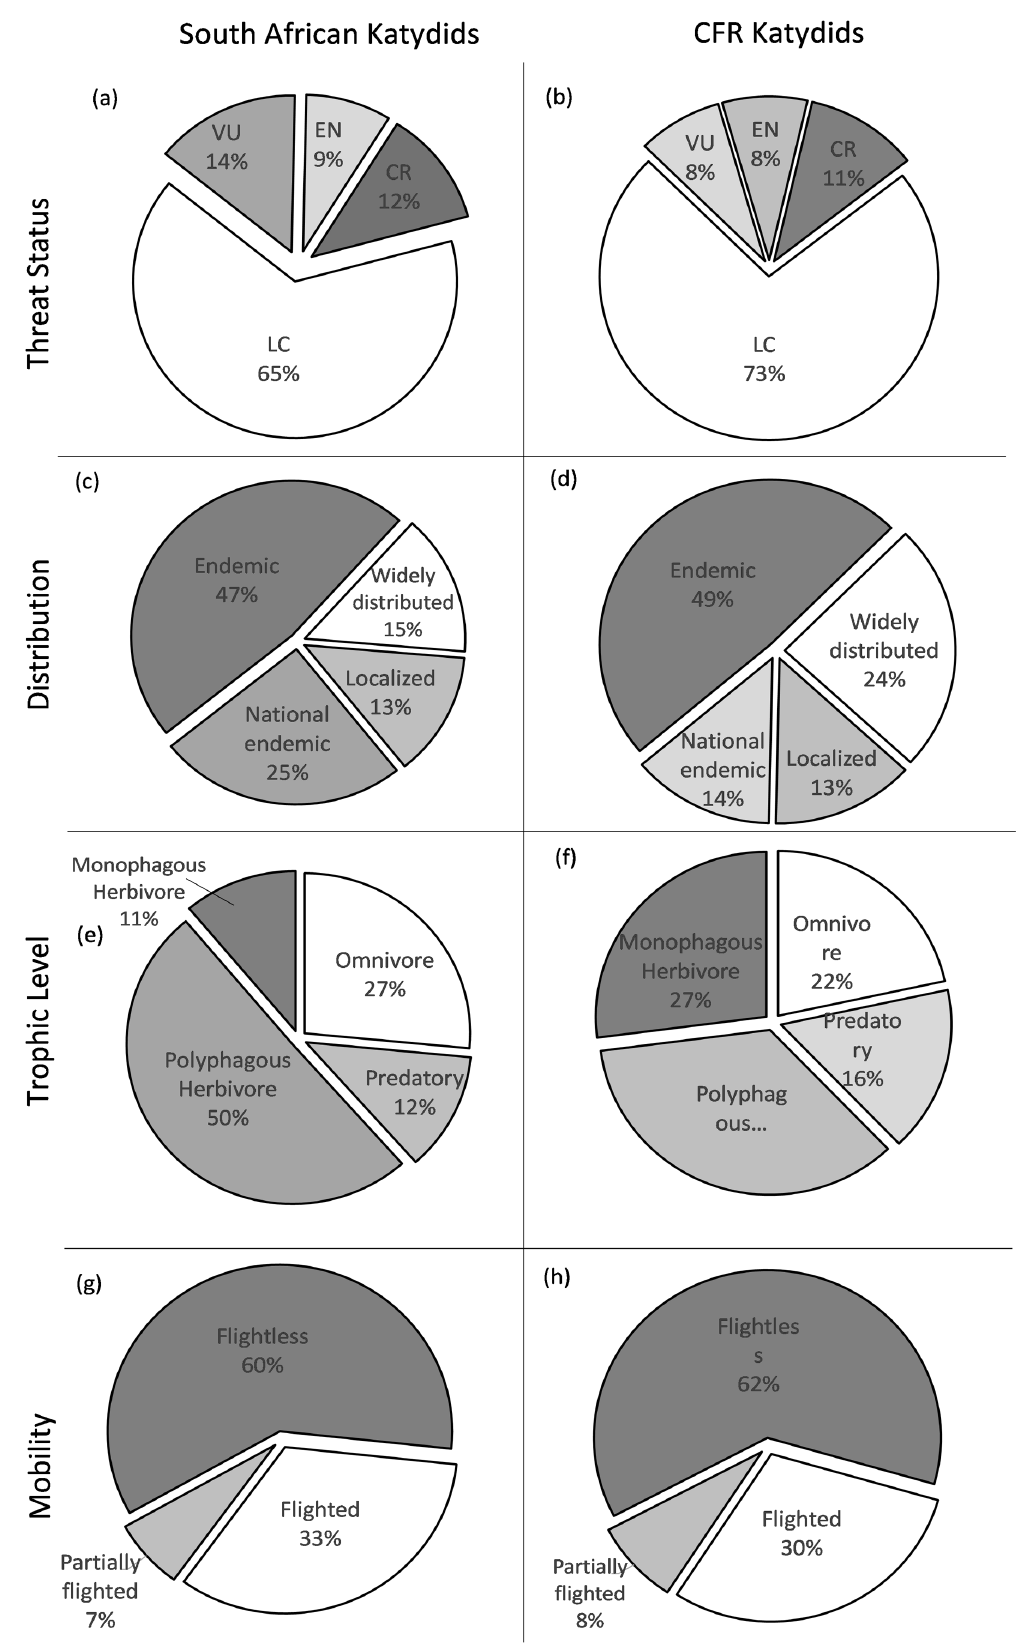
Figure 1. Proportion of South African ( A, C, E, G ) and Cape Floristic Region ( B, D, F, H ) katydid assemblages as characterised by the KBI assessment criteria (Threat Status, Distribution, Trophic level and